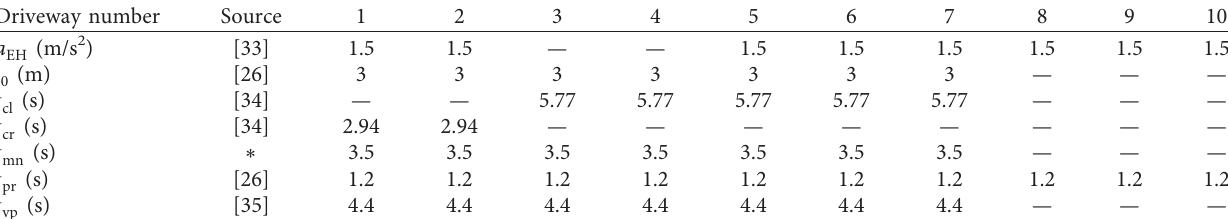
Table 6: Assumed values for driveway traffic